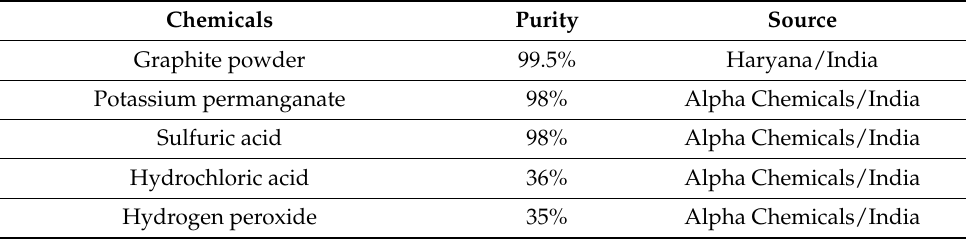
Table 1. The chemicals used in the preparation of the rGO, Fe 3 O 4 @rGO, and Fe 3 O 4 @rGO/PU composite